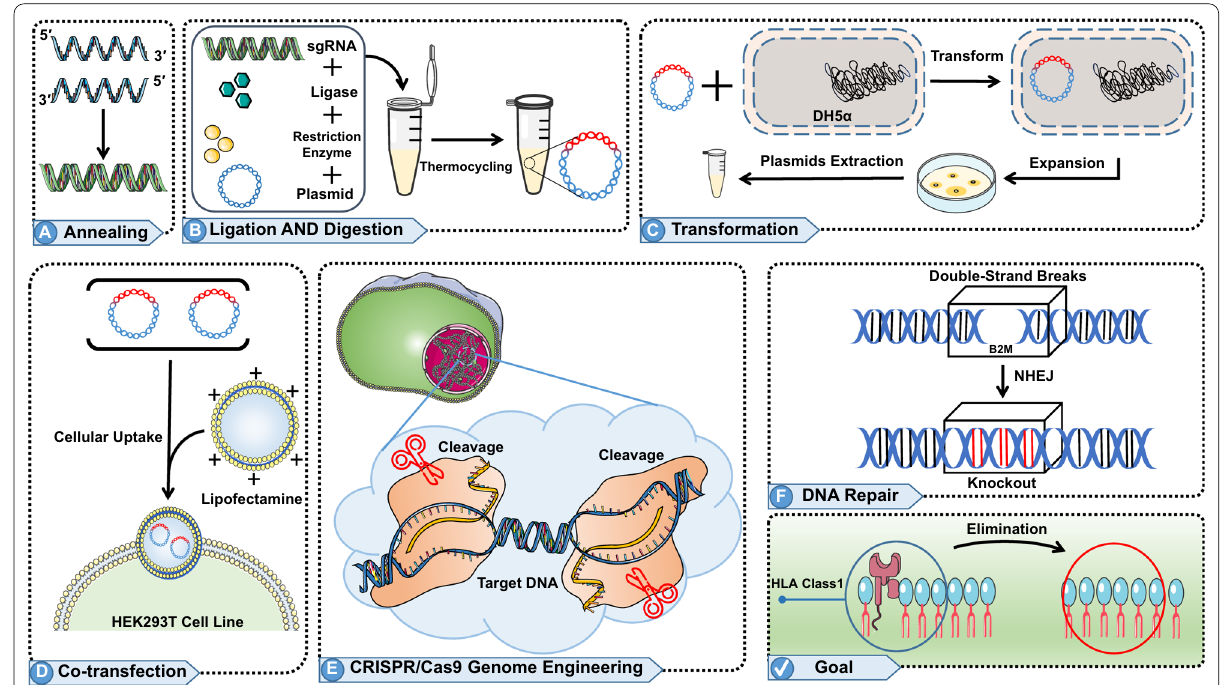
Fig. 3 A Schematic flowchart of the experimental procedure for knocking out B2M gene out by CRISPR/Cas9 genome editing system. A Generating the desired gRNA through designed guide oligos under temperature condition. B Inserting the gRNA into backbone of PX458 vector (red region) followed by ejection of two-cutting selective sites. C Transforming the resulting vectors into E. coli DH5α and isolating vectors from colonies. D Co-transfecting the collected vectors into HEK293T cell line using commercially transfection reagent, Lipofectamine. E Directing the gRNA into the specific genomic site and editing the targeted DNA through Cas9 protein. F Rejoining the fragment sites by error-prone NHEJ pathway and knocking out B2M